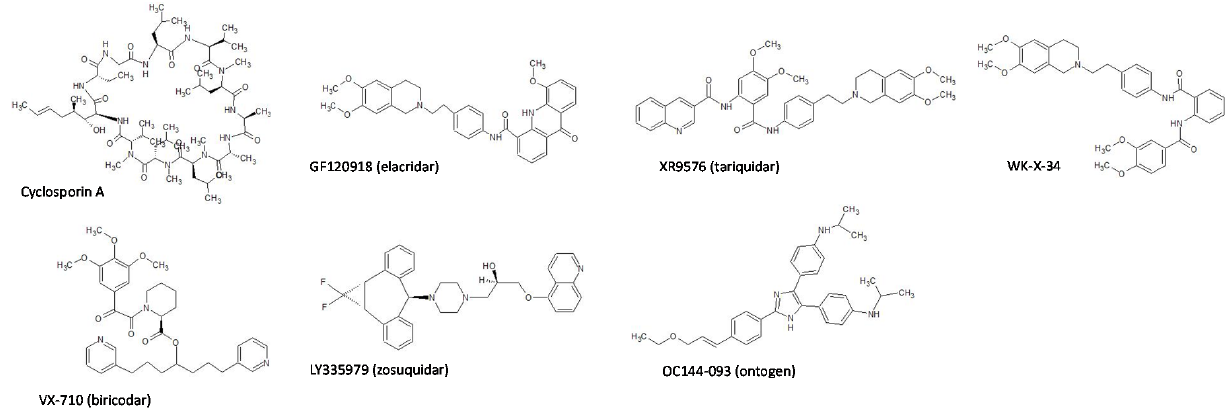
Figure 1. Chemical structures of cyclosporin A and P-glycoprotein P-gp inhibitors used in this study [20,28,29].